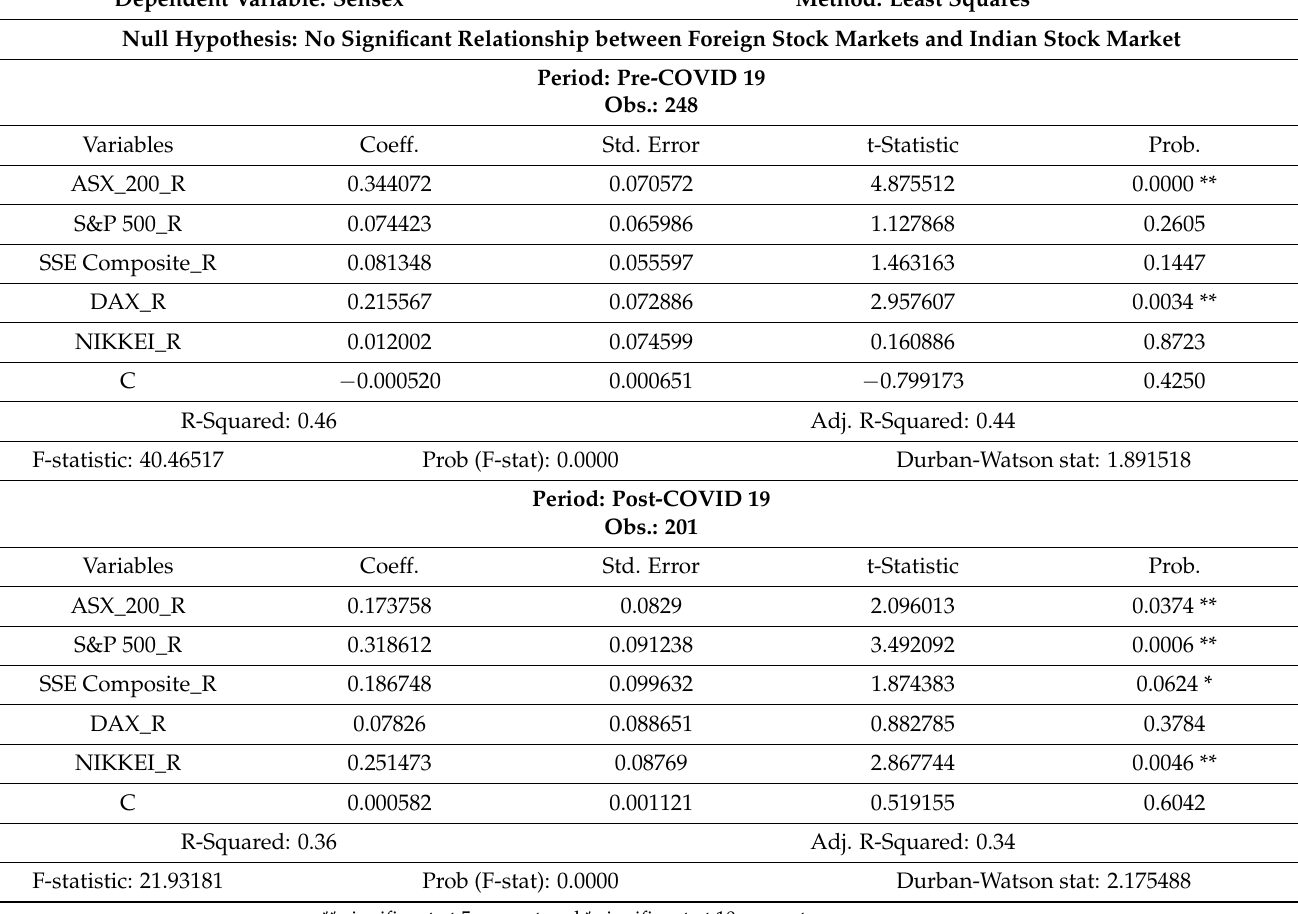
Table 4. OLS regression during Pre-and-Post COVID-19